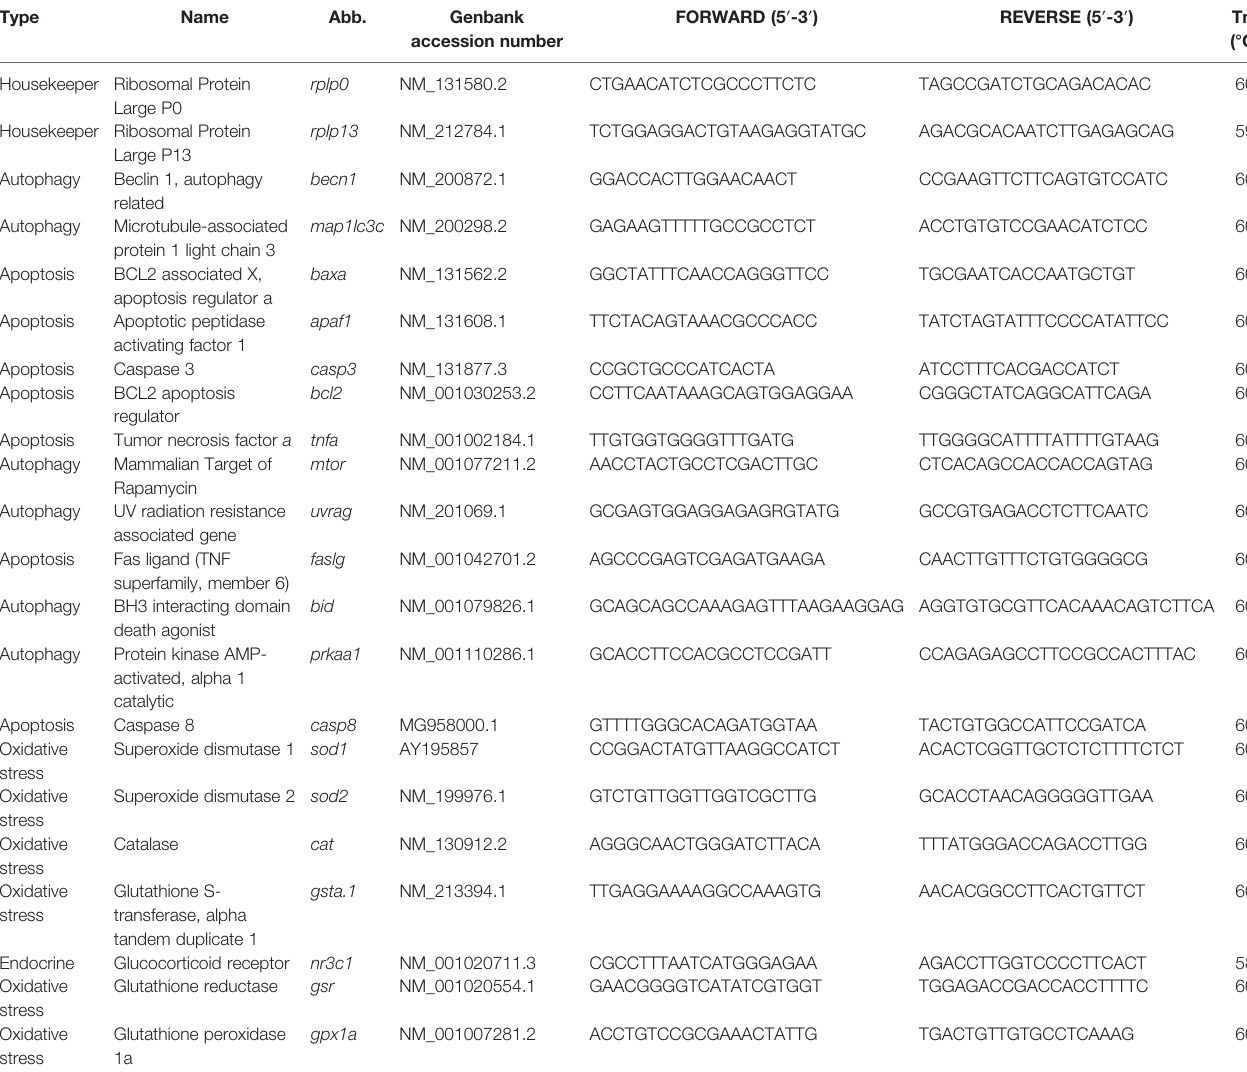
TABLE 1 | List of primers for Real Time qPCR